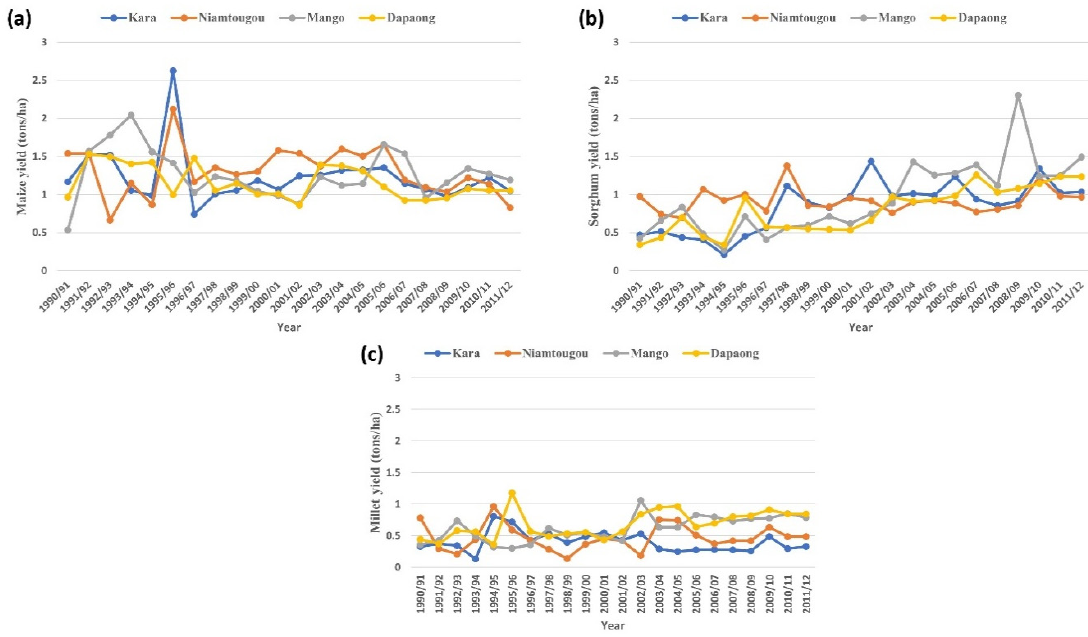
Figure 6. Trend in the yield data of ( a ) maize, ( b ) sorghum and ( c ) millet.